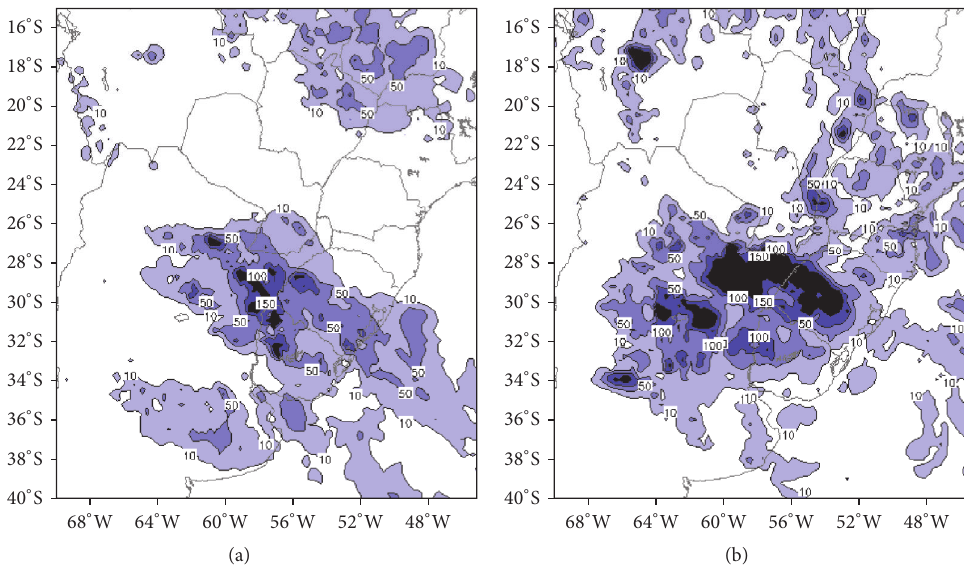
Figure 3: Satellite-estimated 48 hr rainfall accumulation (in mm) over the La Plata Basin valid at (a) 1200Z 22 October 2008 and (b) 1200Z 20 January 2010. Source: Climate Prediction Center merged microwave